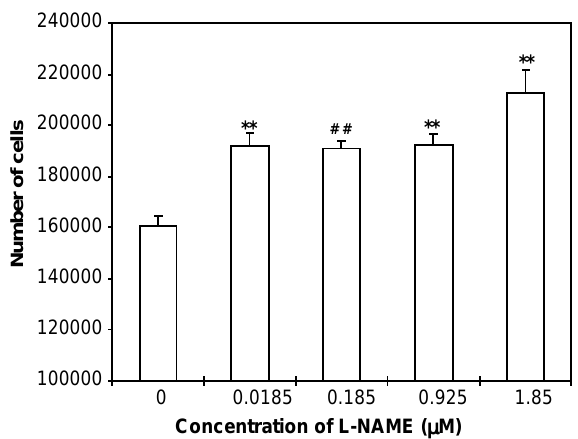
FIG. 2. Adhesion of control and L-NAME-pretreated rat peritoneal macrophages to quiescent monolayers of rat epitenon cells. Macrophages had been pretreated with different concentrations of L-NAME for 24 h. Error bars represent standard error of the means. **p B / 0.005 and ## p B / 0.001 versus control untreated macrophages.